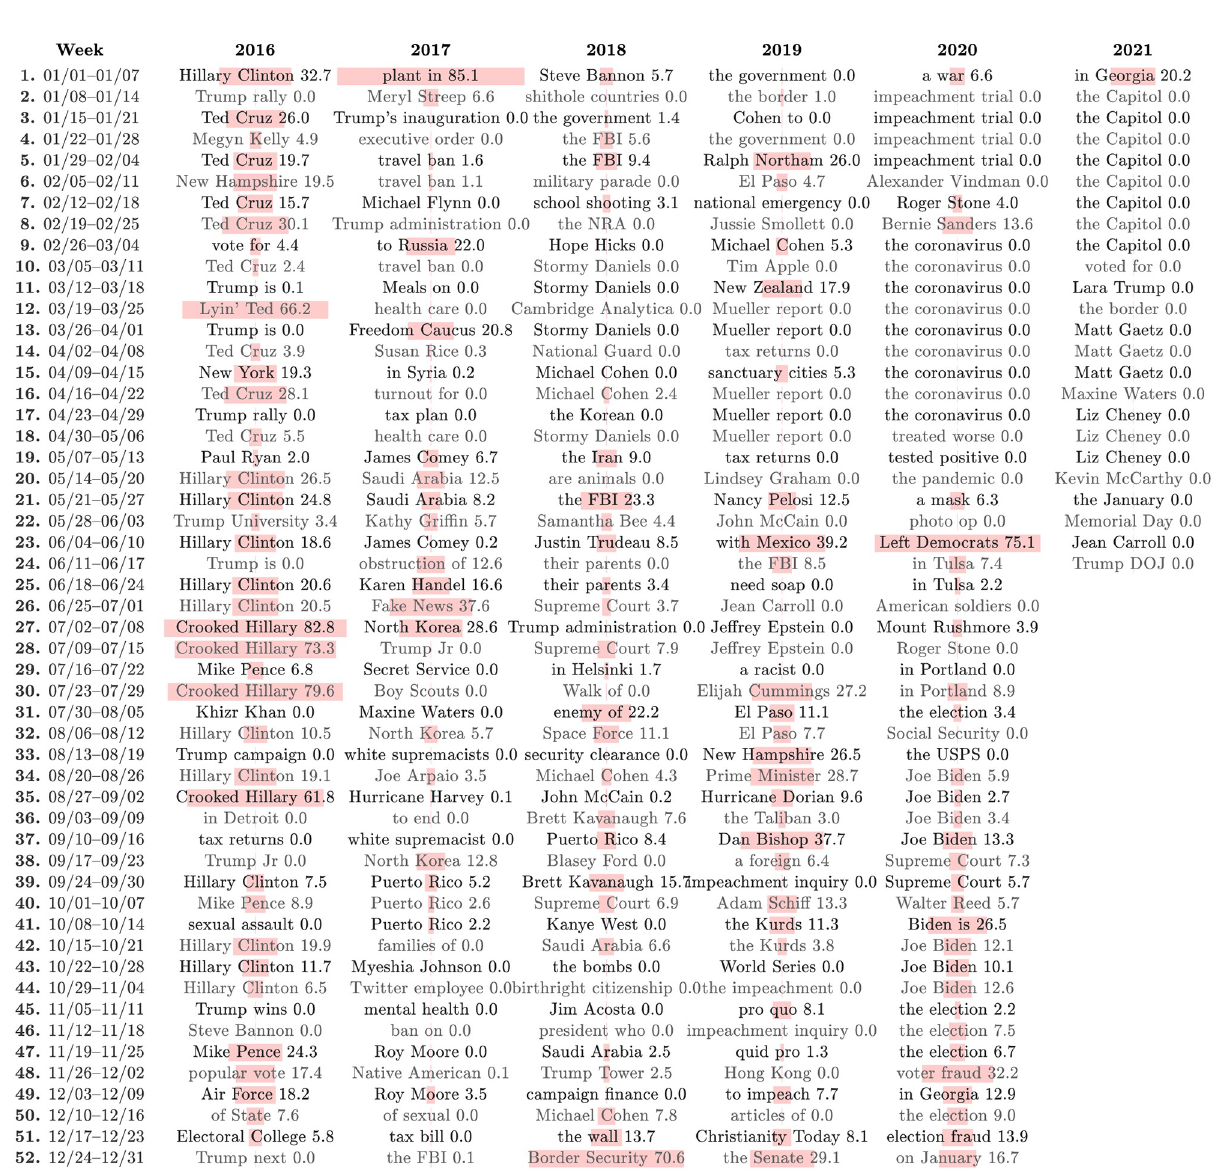
Fig 2. Computational timeline of narratively dominant 2-grams surrounding Trump at the week scale. The timeline’s construction and the plot’s details are analogous to that of Fig 2. The n -grams in both timelines match (‘coronavirus’ and ‘the coronavirus’), expand on each other (‘bounties’ and ‘American troops’), or point to different stories (‘Mueller’ and ‘Stormy Daniels’). See the paper’s Online Appendices (compstorylab.org/ trumpstoryturbulence/) for a day-scale visualization of the top 10 most narratively dominant 2-grams in Trump-matching